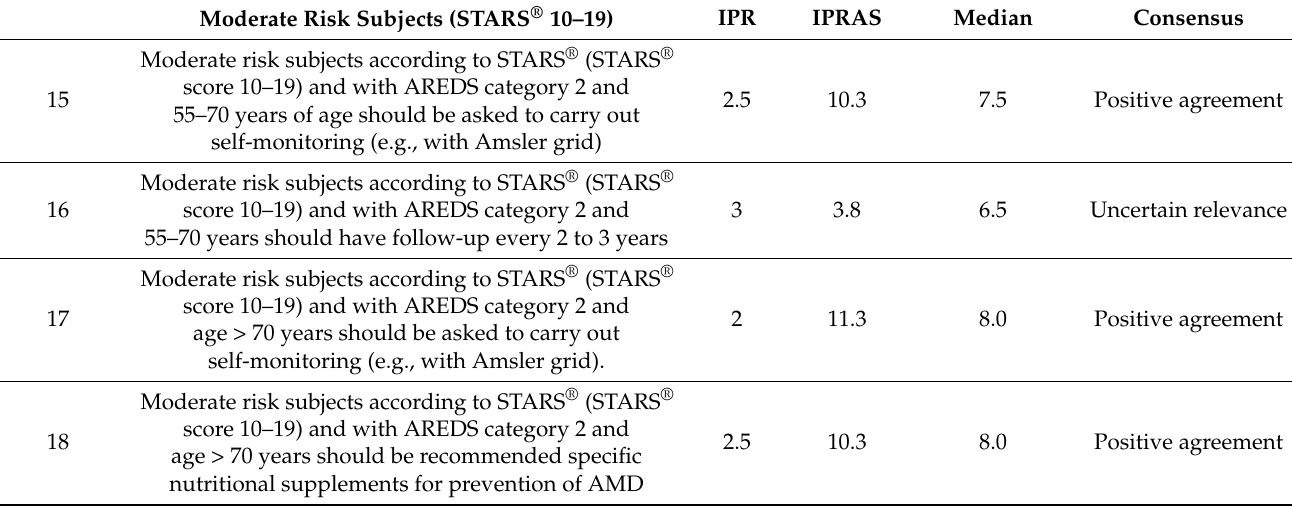
Table 2. Consensus statements for subjects with moderate and high risk of developing